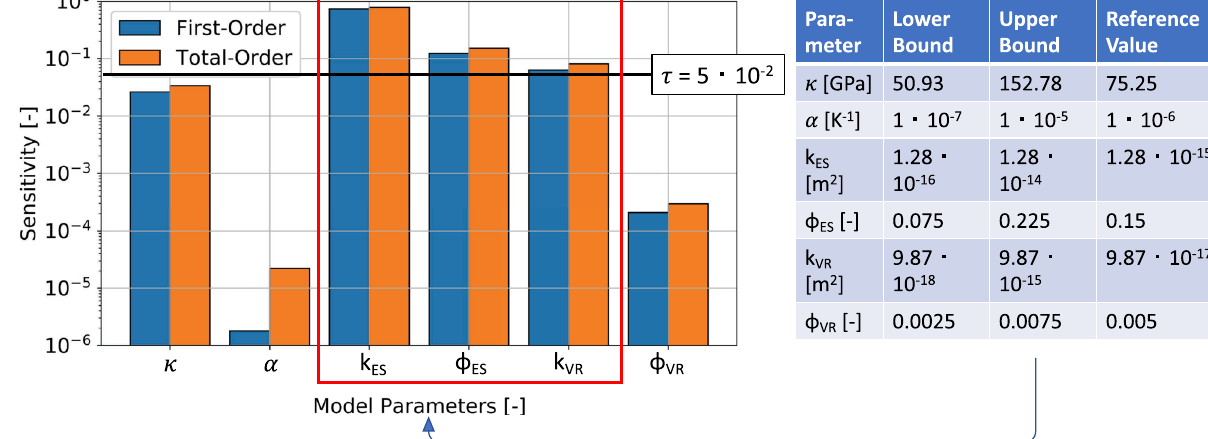
Figure 2. Global sensitivity analysis for the model of Groß Schönebeck with a threshold value of 5 × 10 − well as the lower and upper bounds presented on the right side. Note that κ denotes the solid bulk modulus, α the thermal expansion coefficient, k the permeability, φ the porosity, and the subscripts ES and VR the Elbe sandstone I layer, and the Volcanic rocks,